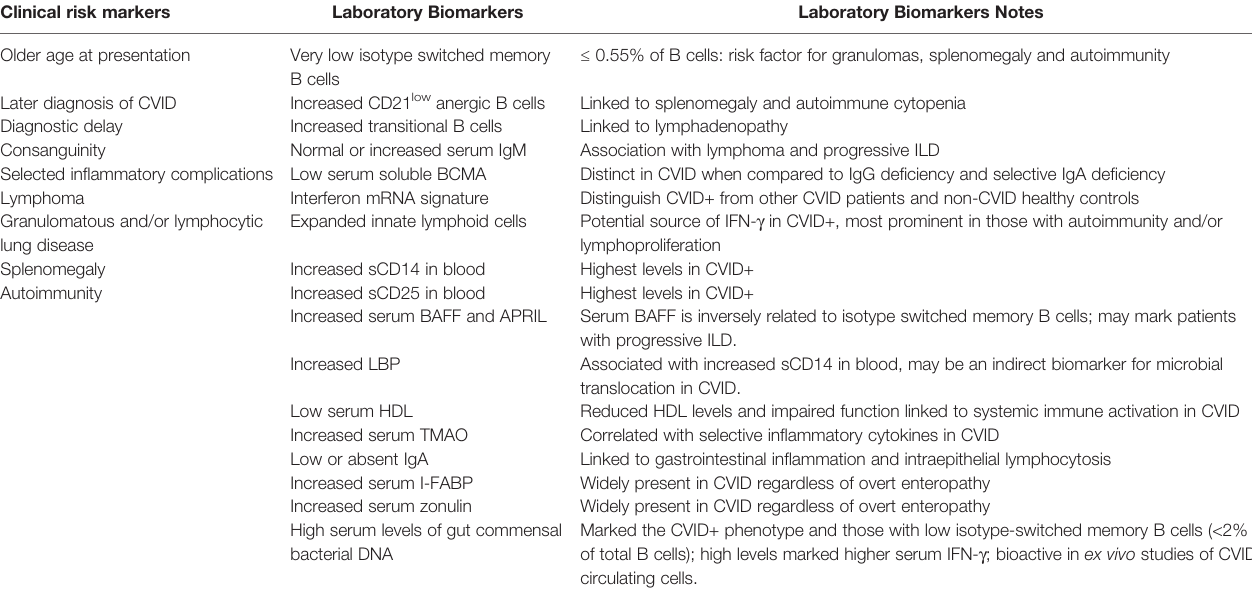
TABLE 2 | Relevant clinical and laboratory biomarkers in